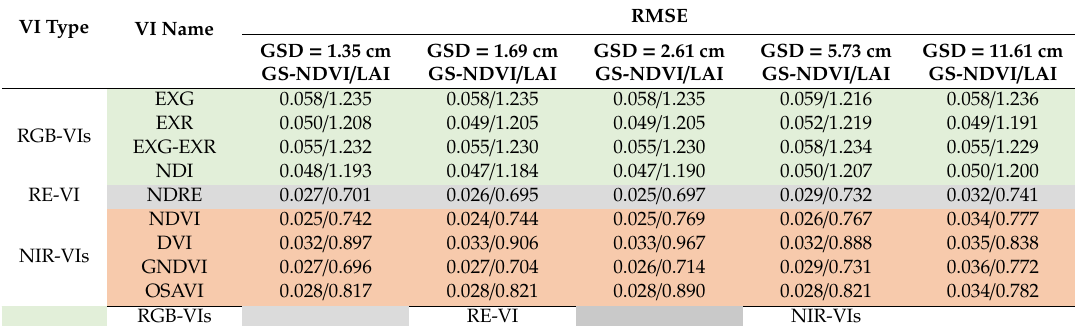
Table 5. Root mean square error (RMSE) between ground-measured parameters (GS-NDVI and LAI) and nine UAV-VIs 1 .